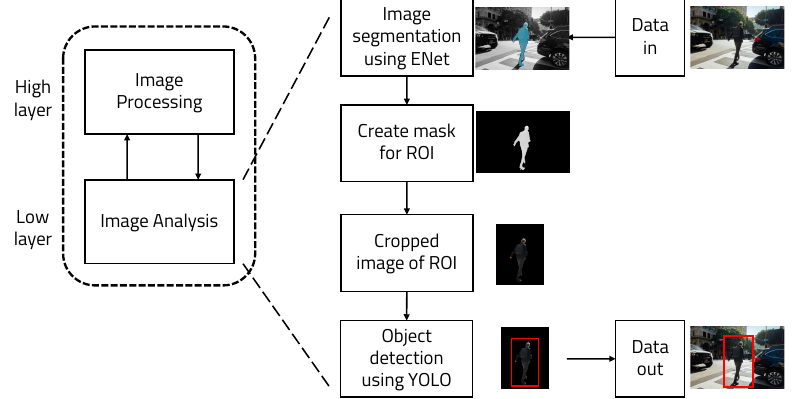
Figure 3. Overall algorithm used for real-time object